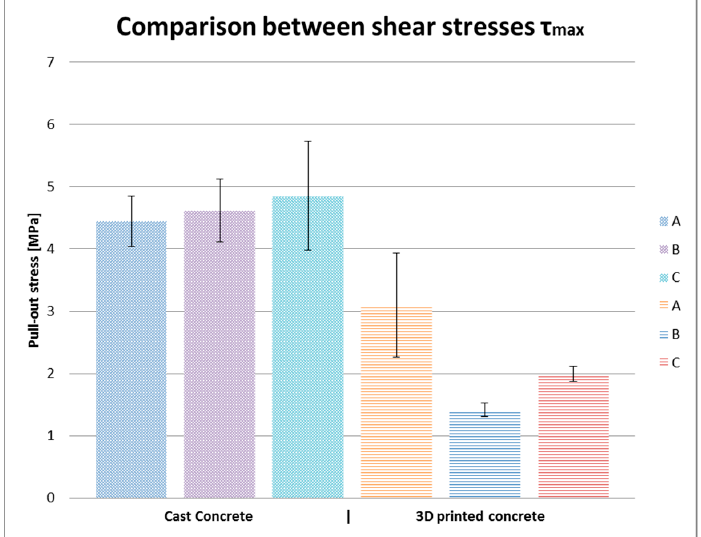
Figure 11. Comparison of average ultimate bond stress in cast and printed specimen.